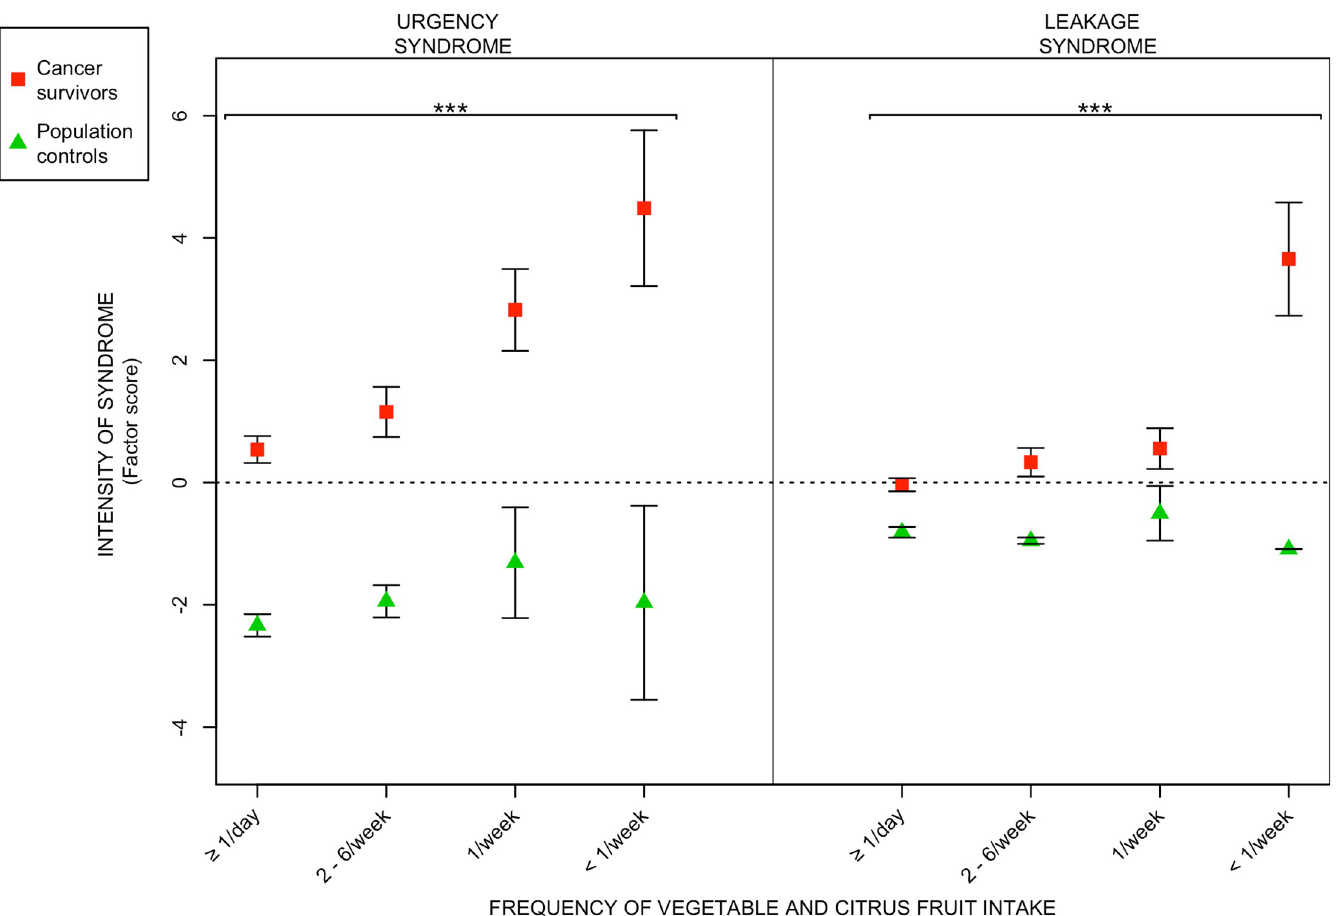
Fig 2. Relationship between radiation-induced survivorship syndromes and frequency of vegetable and citrus fruit intake. The figure depicts the relationships between frequency of combined intake of beans and lentils, cabbage and broccoli, onion and garlic, grated vegetables together with citrus fruits (x-axis) and intensities (factor scores) of the two radiation-induced survivorship syndromes (y-axis) defecation-urgency syndrome and fecal-leakage syndrome among long-term gynecological cancer survivors and population controls. Red squares and green triangles denote the mean syndrome intensities within certain vegetable and citrus intake frequency levels. Vertical black lines stretch between plus-minus the standard error of the mean. Asterisks correspond to significance levels of the Spearman correlations between syndrome intensities and frequency of vegetable and citrus intake according to: p � 0.001 - ��� , 0.001 < p � 0.01 - �� . 0.01 < p � 0.05 - � . Estimates of the Spearman correlations are found in Tables 2 and